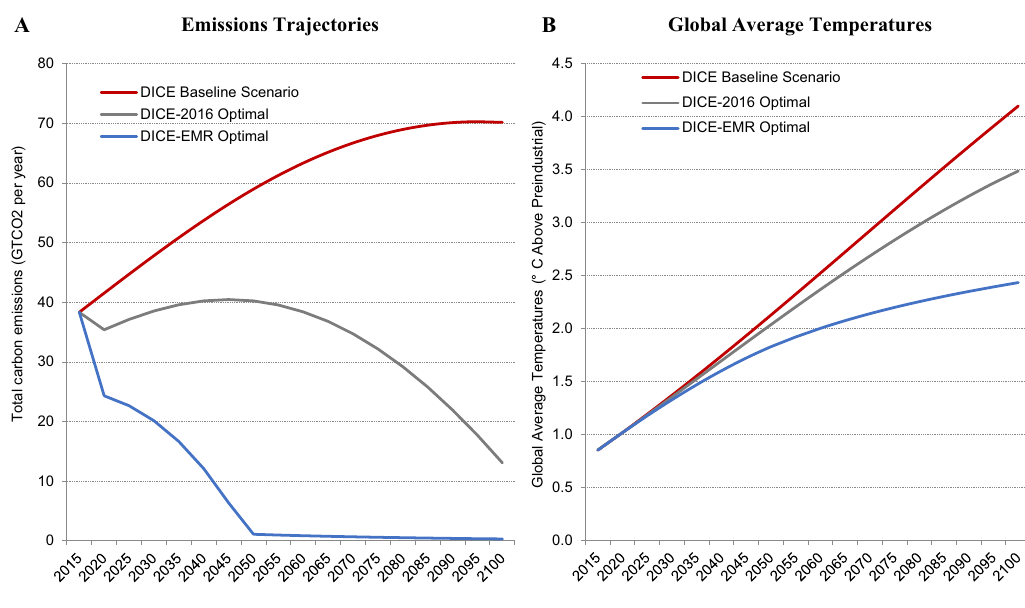
Fig. 2 Optimal Climate Policy. Integrated assessment models (IAMs) assess the cost of reducing emissions and the damages from climate change in a dynamic general equilibrium model that includes coupled interactions between the economy and the climate. They can be used normatively to determine optimal climate policy. They do this by using optimal control to determine a path of emissions trajectories that optimizes the net present value of social welfare. A Optimal climate policy in DICE-2016 involves gradual emissions reductions starting in 2050 while optimal climate policy in DICE-EMR involves immediate emissions reductions and full decarbonization by 2050. B Optimal climate policy in DICE-2016 results in 3.5 °C warming by 2100 while optimal climate policy in DICE-EMR results in 2.4 °C warming by